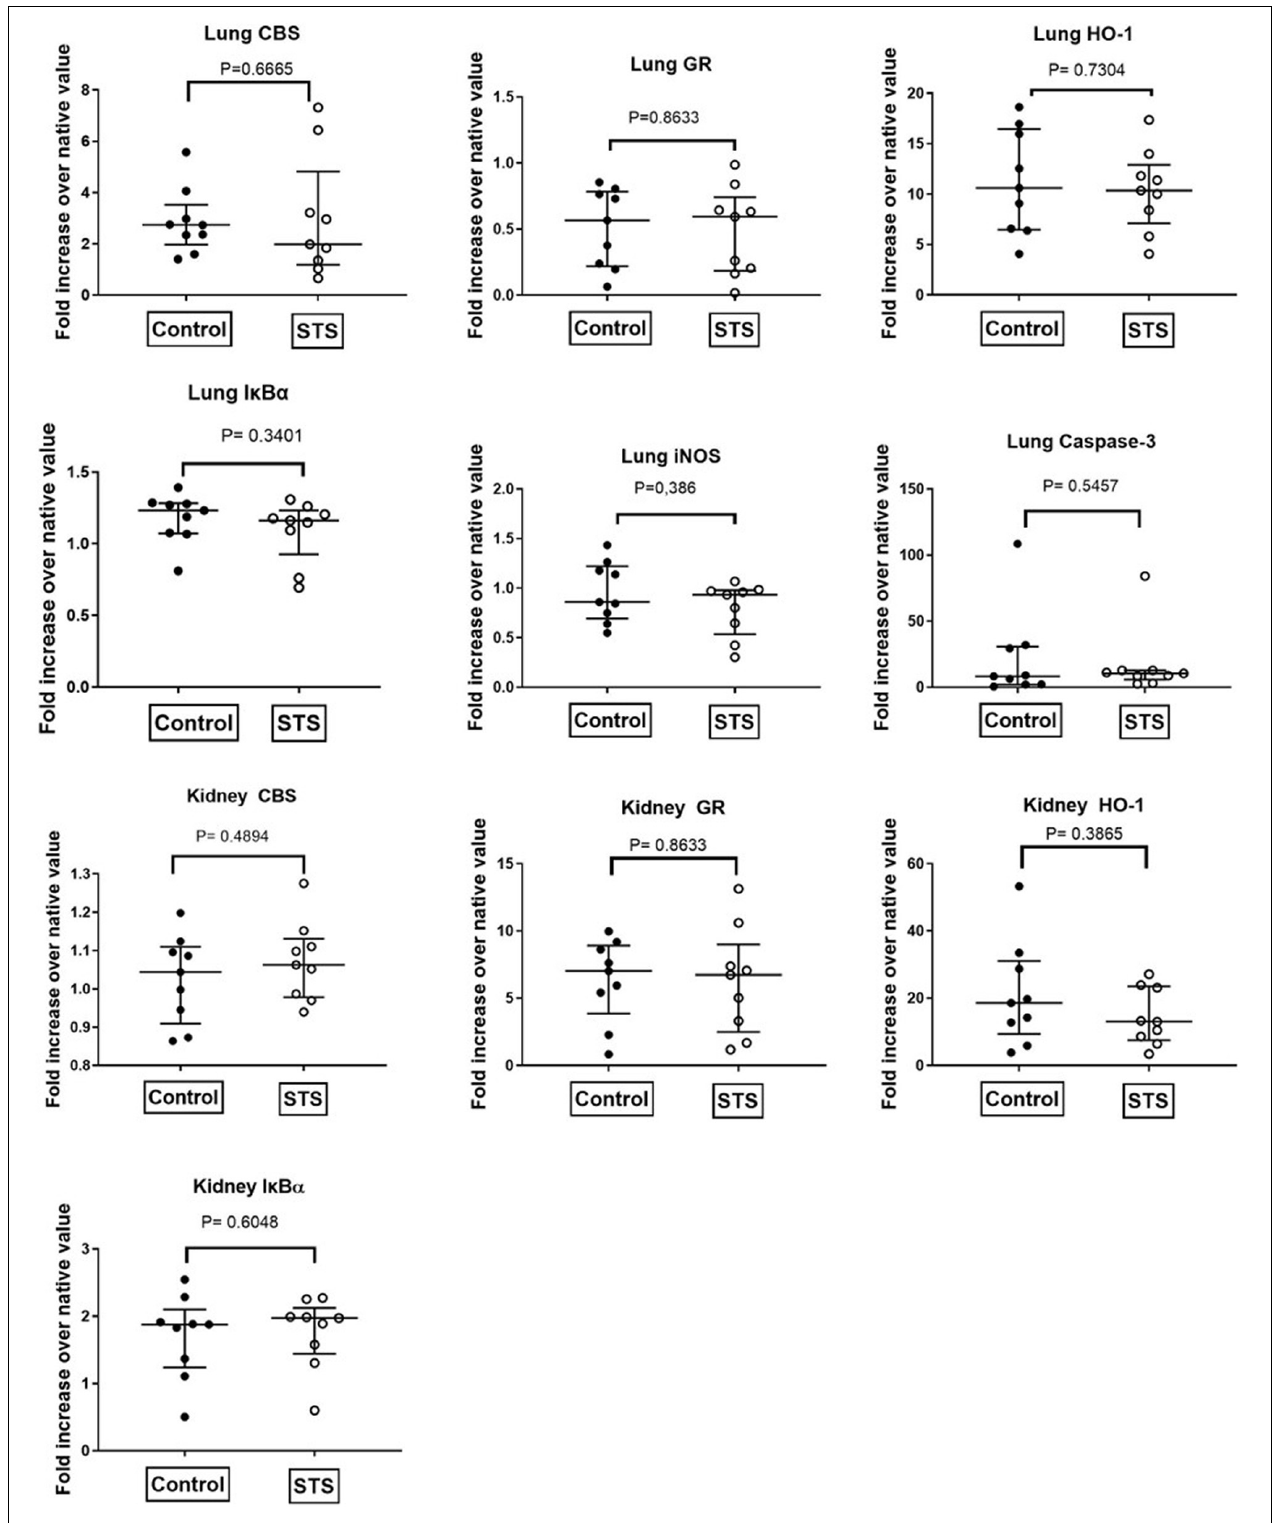
FIGURE 2 | Quantitative analysis of immunoblots of lung and kidney tissue. CBS, Cystathionine- β -synthase; GR, glucocorticoid receptor; HO-1, heme-oxygenase 1; I κ B α , nuclear factor of kappa light polypeptide gene enhancer in B-cells inhibitor, alpha; iNOS, inducible nitric oxide synthase.